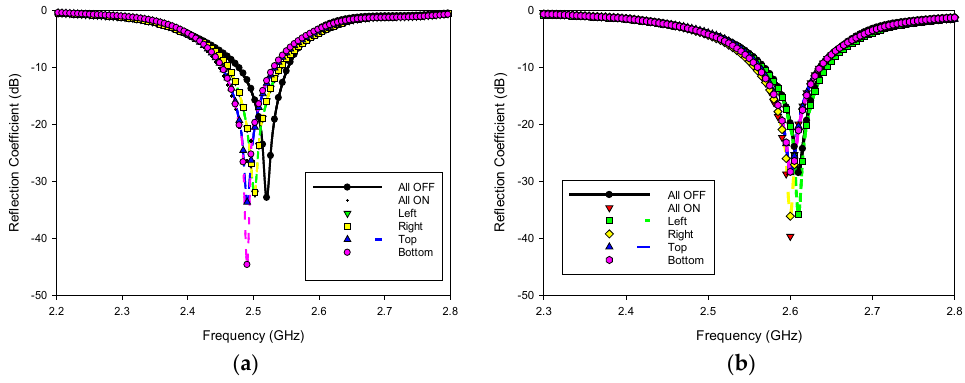
Figure 8. Reflection coefficient: ( a ) simulated ; and ( b ) m easured.